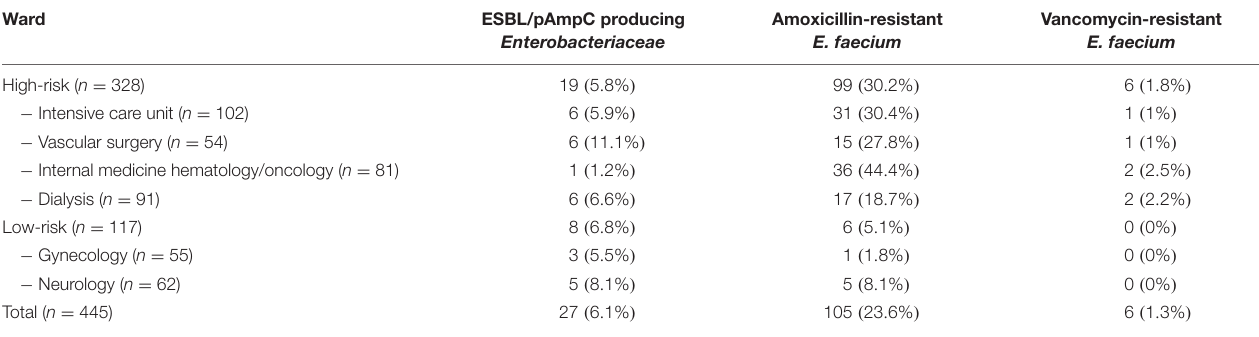
TABLE 1 | Distribution of ESBL/pAmpC producing Enterobacteriaceae , and amoxicillin- and vancomycin-resistant E. faecium among the different wards in Dutch hospitals.